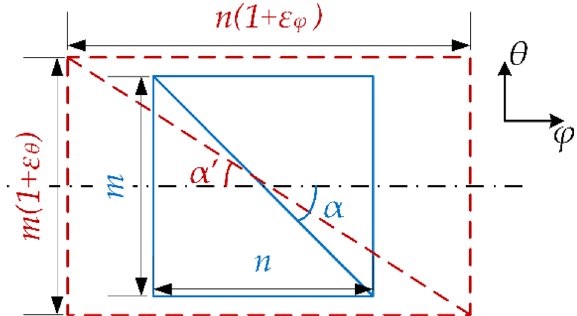
Figure 2. The slight change of winding angle under high internal